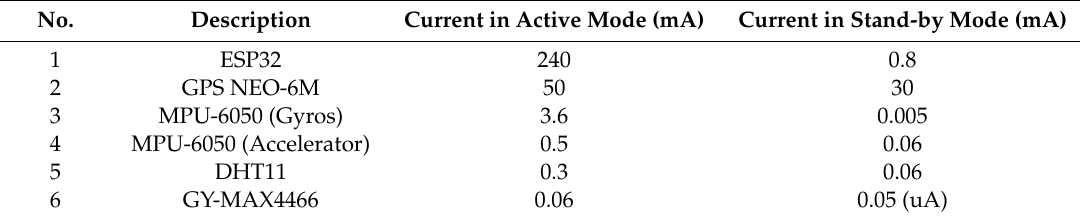
Table 1. List of currents in both active mode and stand-by mode for each